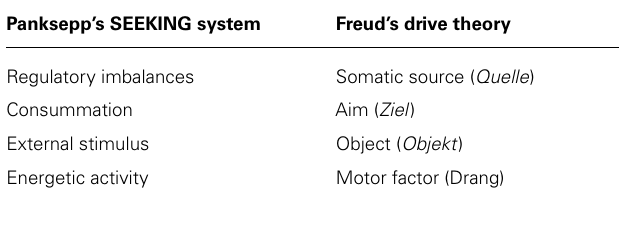
Table 1 | Shevrin’s (2003) proposition of the parallels between the four parts of Panksepp’s SEEKING system and the four parts of Freud’s definition of the